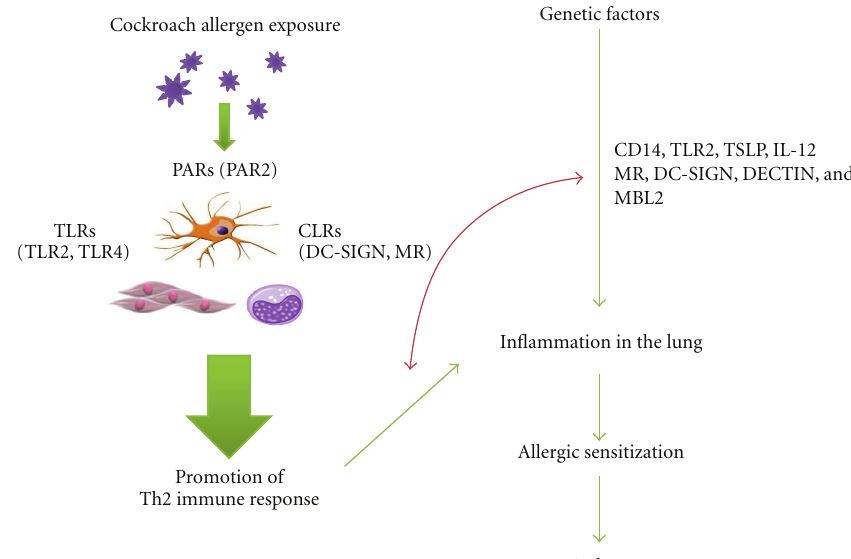
Figure 1: The mechanism of cockroach allergen-induced allergic sensitization. Cockroach-derived proteases can disturb airway epithelial integrity and lead to an increased penetration of cockroach allergen, which can activate innate immune cells (e.g., dendritic cells (DCs)) via binding to Toll-like receptors (TLRs) or C-type lectin receptors. The activated DCs can direct cells of the adaptive immune system to a promotion of Th2 cell response and subsequently increase risk of sensitization. On the other hand, genetic factors, particularly genetic variants in TLRs, CLRs, CD14, either alone or in interaction with cockroach exposure, confer the susceptibility to increased risk of cockroach sensitization and subsequently inflammation in the lung and